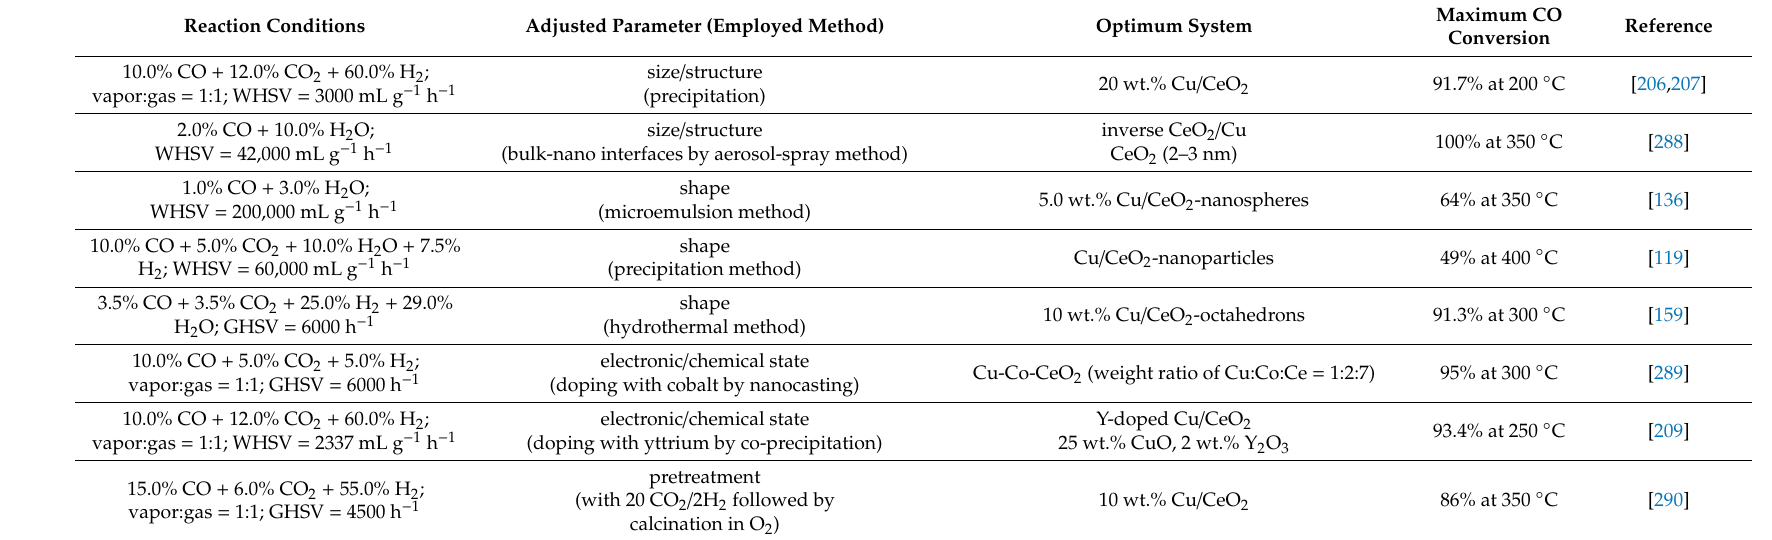
Table 4. Indicative studies towards adjusting the WGSR performance of CuO-CeO 2